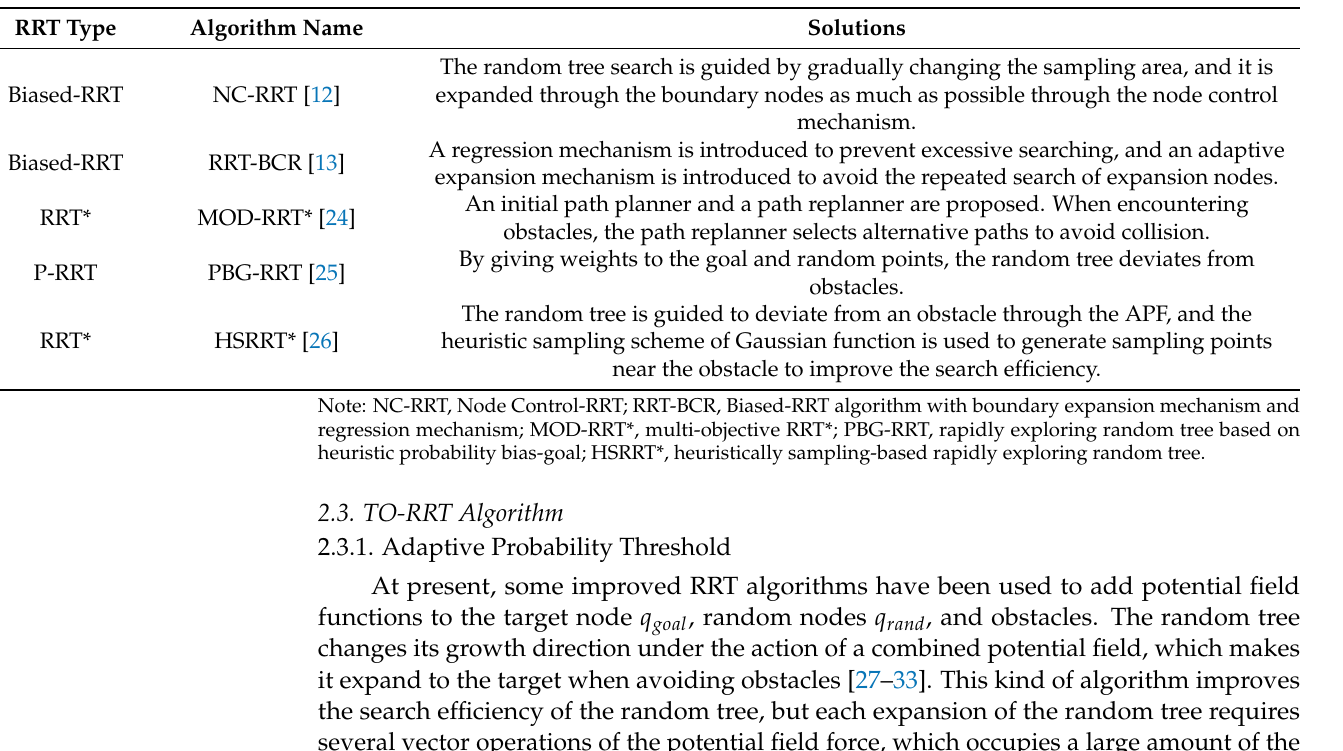
Table 1. Comparison of RRT improvement